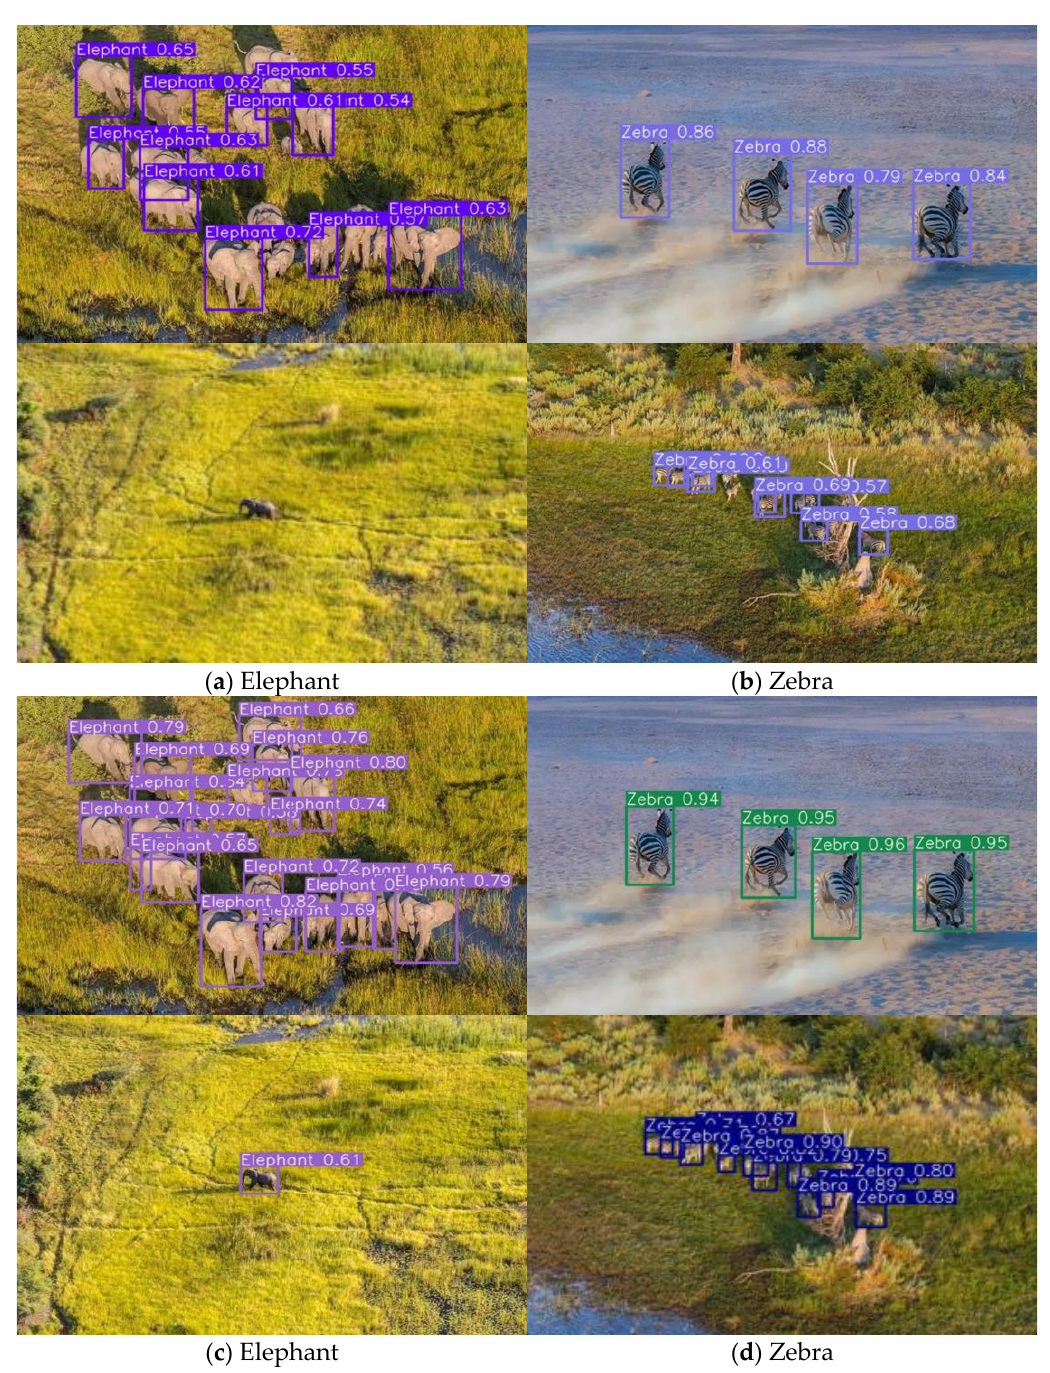
Figure 12. ( a ) Test results for elephant with the original YOLOv5s model; ( b ) test results for zebra with the original YOLOv5s model; ( c ) test results for elephant with the improved YOLOv5s model; ( d ) test results for zebra with the improved YOLOv5s model.